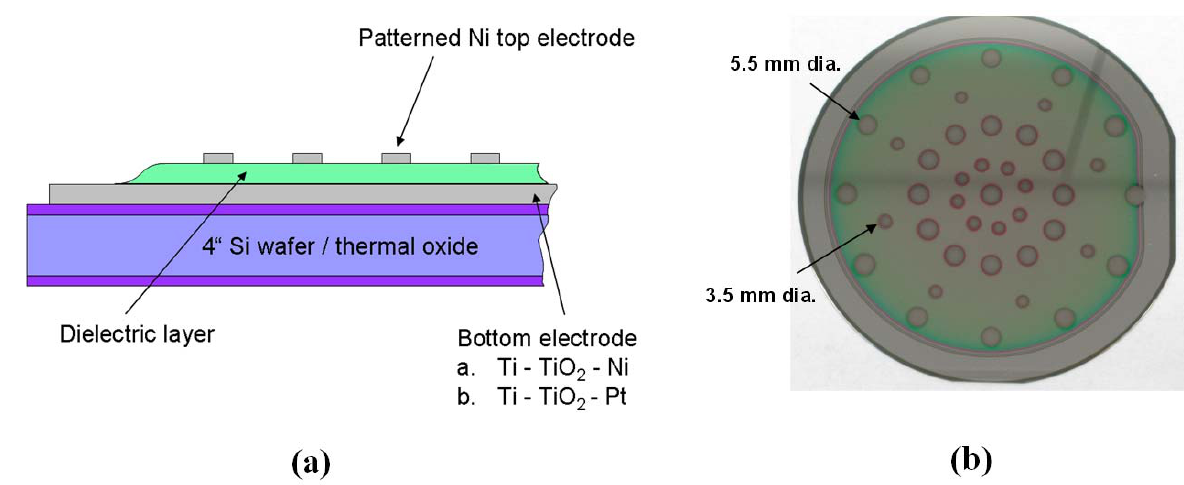
Figure 2. (a) Schematic cross-section of thin-film capacitor structure. (b) Processed wafer after sputter deposition of Ni top electrode dots through a shadow